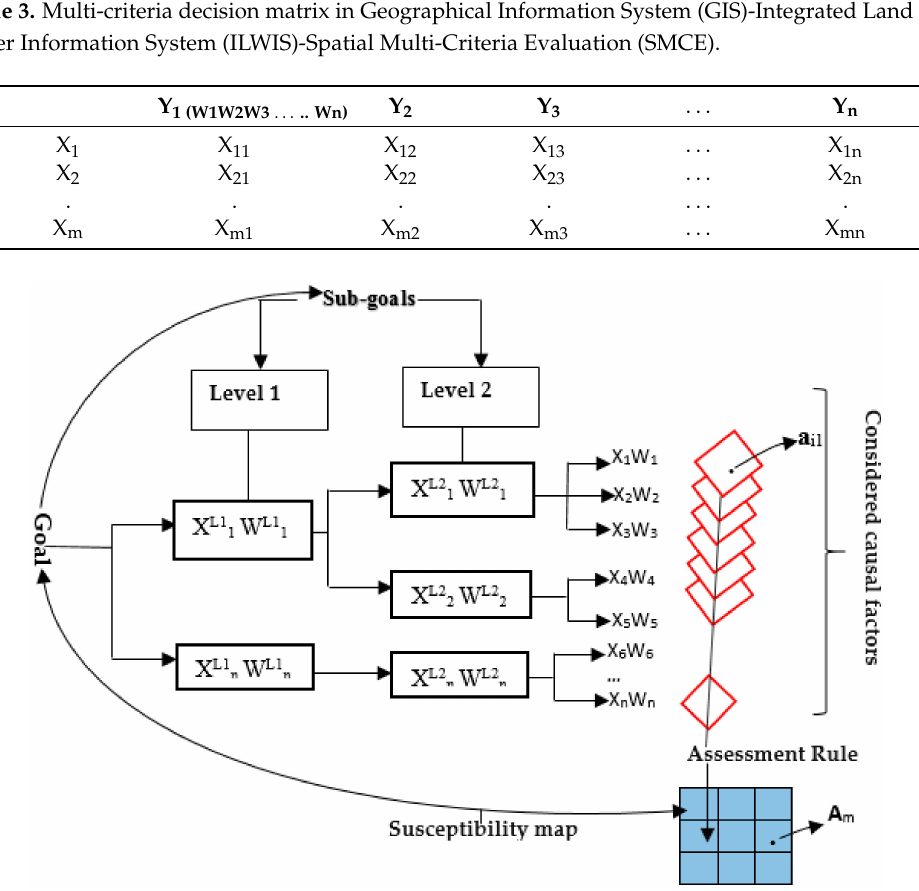
Figure 8. Spatial Multi-Criteria Evaluation Schematic illustration. X, criterion; W, Weight; L, level; A, Alternative; M, number of alternatives; N, number of criteria; a ij , Performance of alternative i and criterion